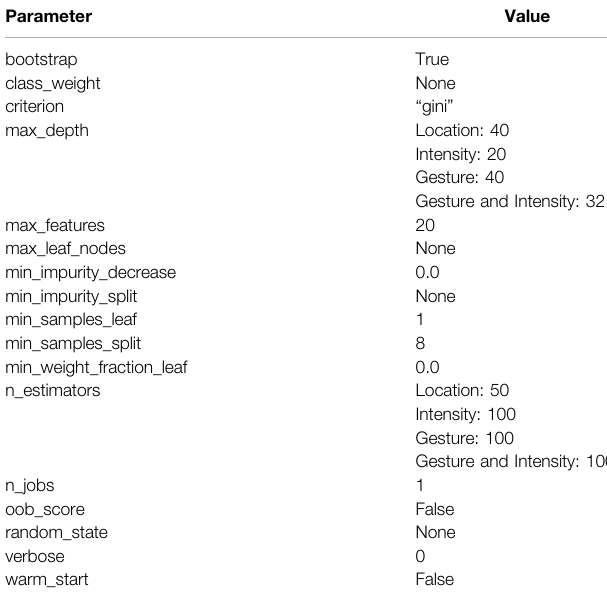
TABLE 2 | The parameter values that were used for the gesture-classi fi cation algorithms. Unless otherwise speci fi ed, the same value was used for classifying contact location, intensity, gesture, and gesture and intensity